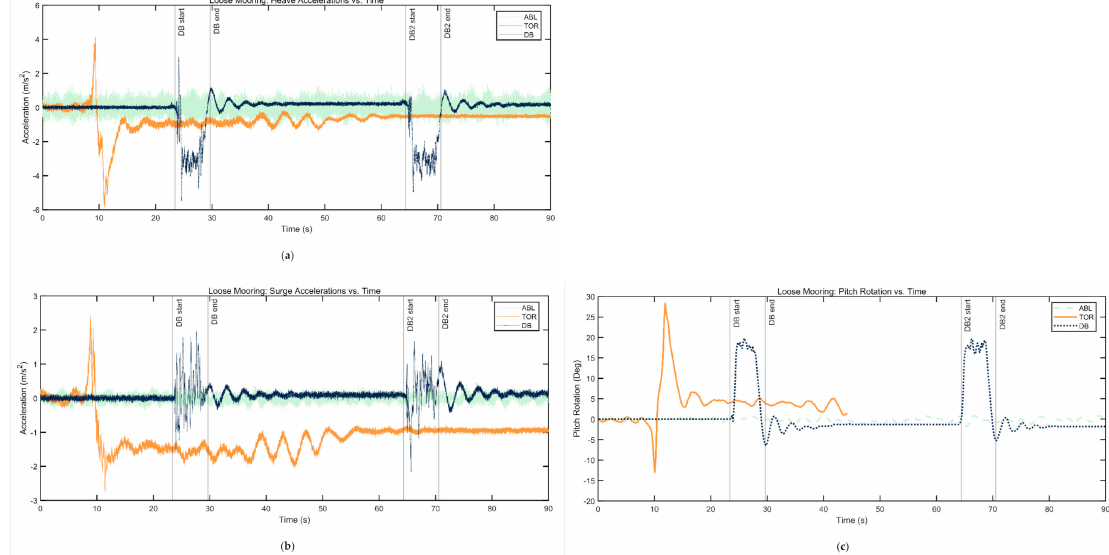
Figure 9. ( a ) Heave acceleration, ( b ) Surge acceleration, and ( c ) Pitch rotation of Configuration 1-Loosely moored base plat-